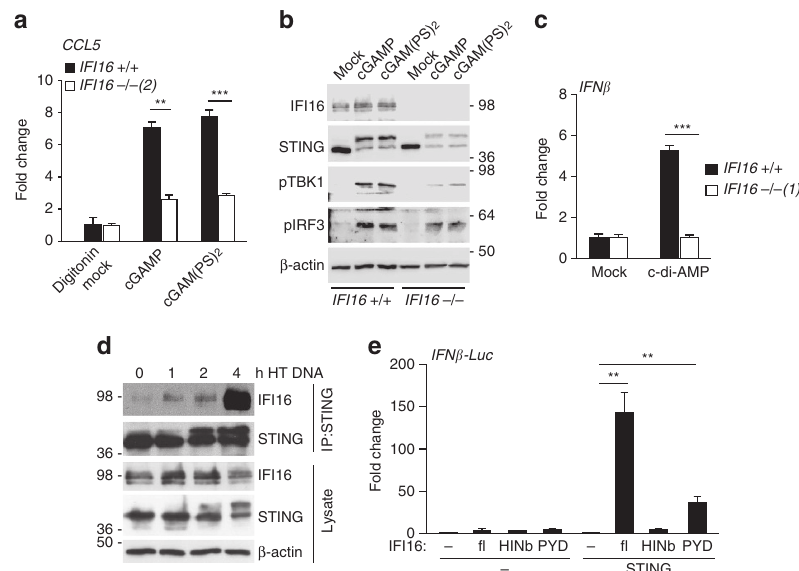
Figure 7 | IFI16 acts on STING to promote its activation by cyclic di-nucleotides. ( a ) IFI16 þ / þ or IFI16 (cid:2) / (cid:2) HaCaT cells were permeabilized with digitonin and infused with 15 m M cGAMP or its non-hydrolysable analogue cGAM(PS) 2 for 6h. CCL5 mRNA expression was analysed by qRT-PCR. ( b ) Cells were permeabilized and infused with 15 m M cGAMP or cGAM(PS) 2 for 4h, and lysates were analysed by western blotting for phosphorylation of STING, TBK1 at Ser172 (pTBK1) and IRF3 at Ser396 (pIRF3). ( c ) Cells were transfected with 100 m gml (cid:2) 1 cyclic di-AMP for 6h, and IFN- b mRNA levels were quantified by qRT-PCR. ( d ) STING was immunoprecipitated from HaCaT cells transfected with 5 m gml (cid:2) 1 HT DNA for the times indicated. Lysates and immunoprecipitates (IP) were analysed by SDS–PAGE and western blotting. ( e ) HEK293Tcells were transfected with a firefly luciferase reporter construct under the control of the IFN b promoter, a Renilla luciferase transfection control, 2ng STING-FLAG plasmid and 150ng empty vector (EV) or IFI16 expression constructs as indicated: full-length IFI16 (fl), the IFI16 HINb domain (HINb), or the IFI16 pyrin domain (PYD). Firefly luciferase activity was measured 24h post transfection, and normalized to Renilla luciferase activity. Data are representative of at least two independent experiments. qRT-PCR and luciferase data are expressed as means of triplicate samples; error bars represent s.d. * P o 0.05, ** P o 0.01, *** P o 0.001 Student’s t